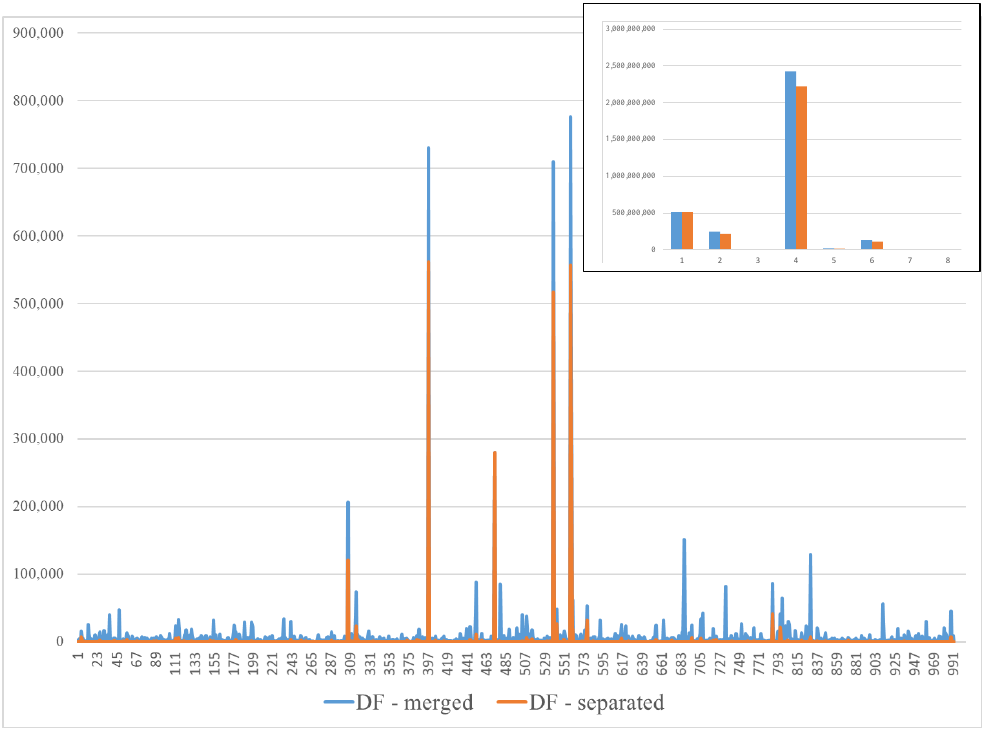
Figure 4. Size of the default funds in the two different cases.